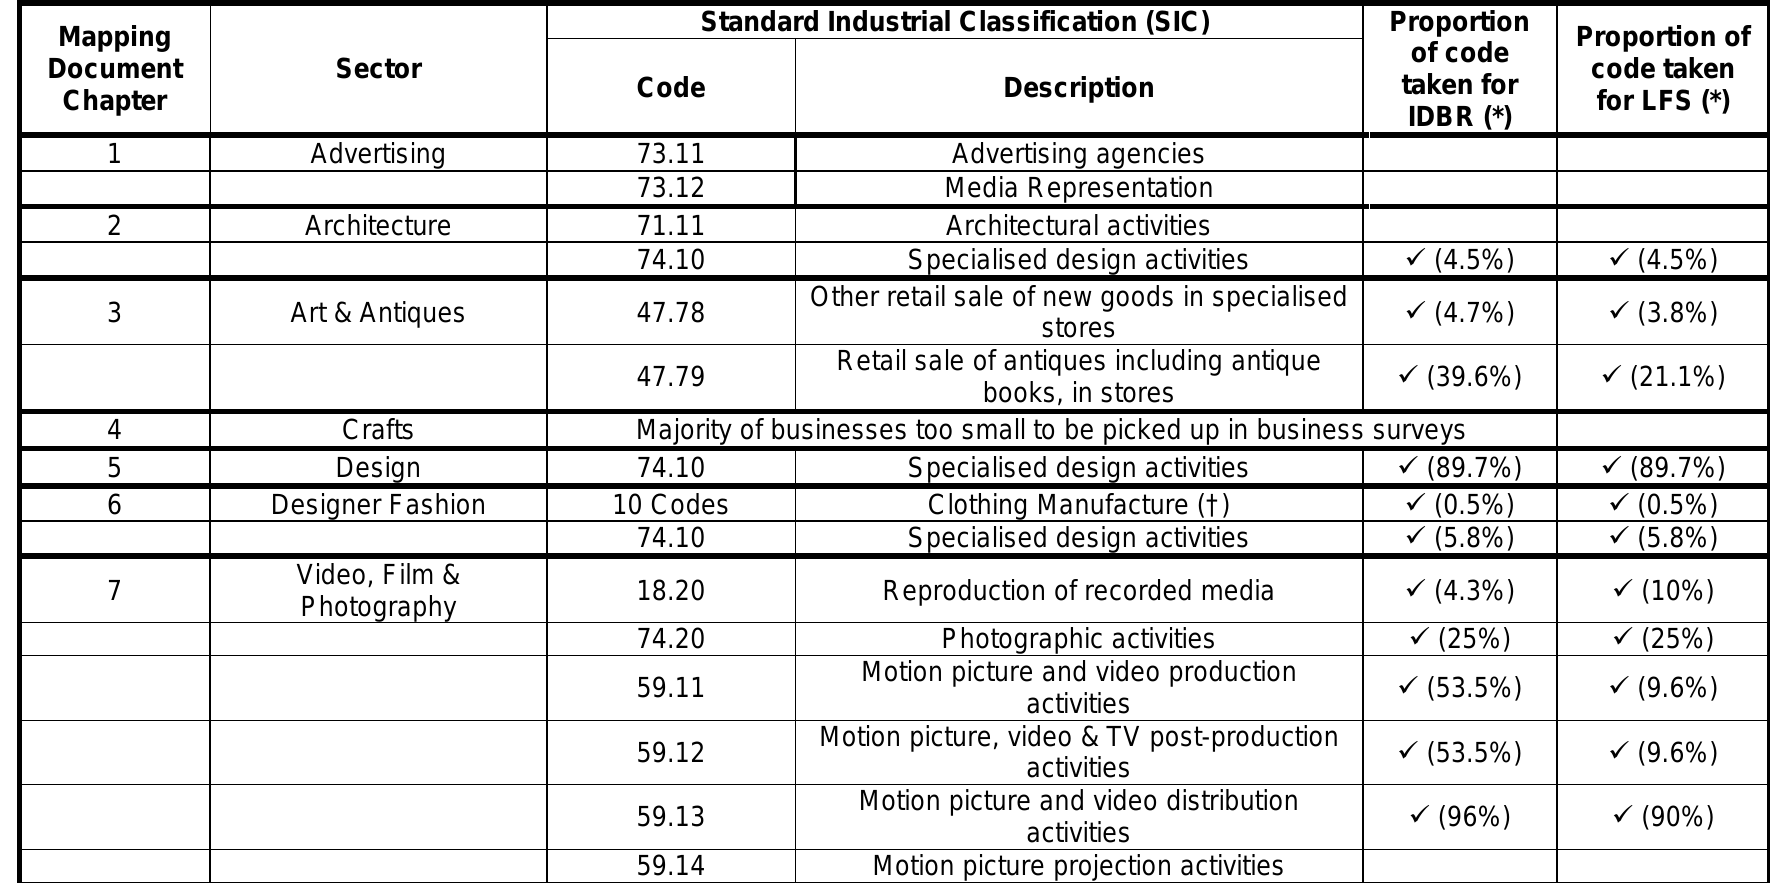
Table A2 – Mapping of the Creative Industries to the 2007 Standard Industrial Classification (SIC) for Inter-Departmental Business Register (IDBR) and Labour Force Survey (LFS)